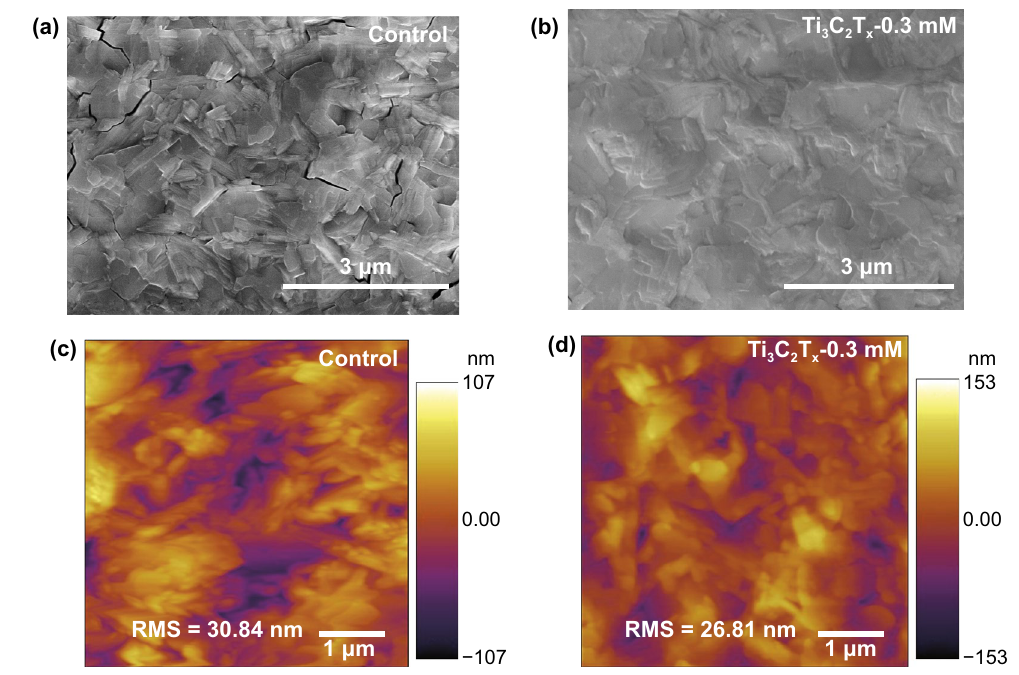
Fig. 3 a , b Top‑view SEM and c , d AFM image of the control and optimized Ti 3 C 2 T x ‑doping perovskite